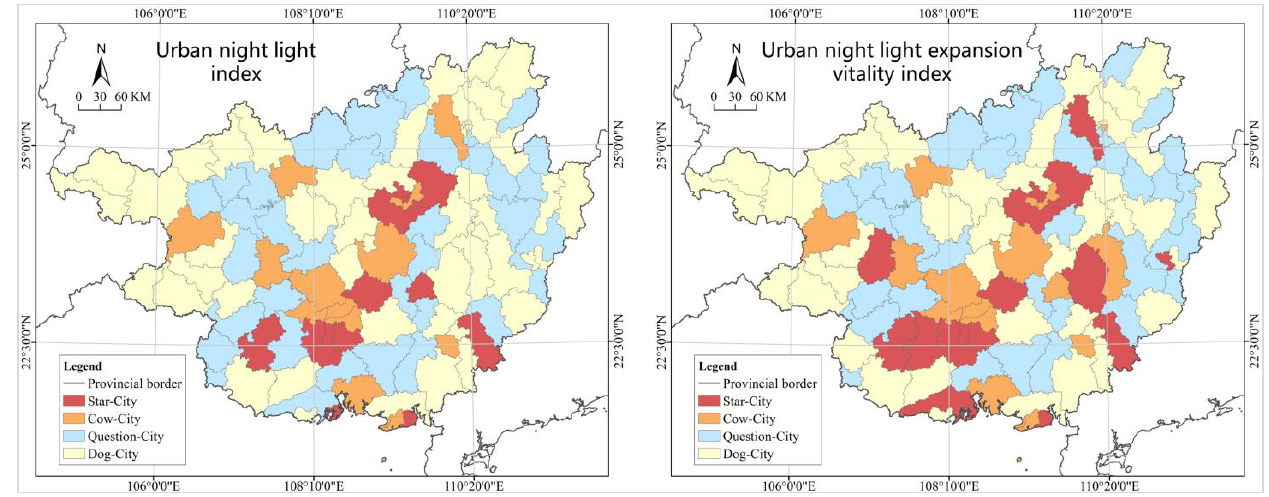
Figure 12. Analysis of the policy zoning of urbanization in Guangxi . Question cities include Longan County, Mashan County, Rongshui County, Sanjiang lan County, Bama County, Fusui County, and Pingxiang City. They are characterized by